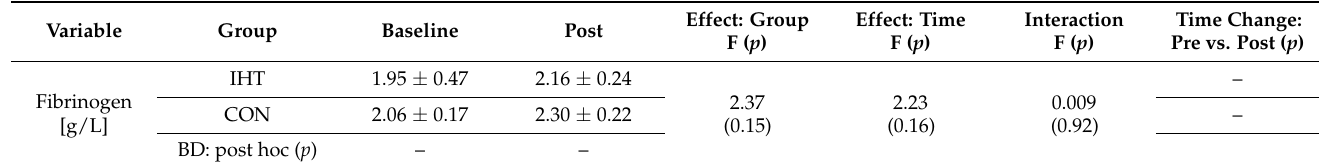
Table 6. Mean values (±SD) of fibrinogen concentrations in rowers training in the hypoxia and normoxia (control) conditions before and after the intervention.